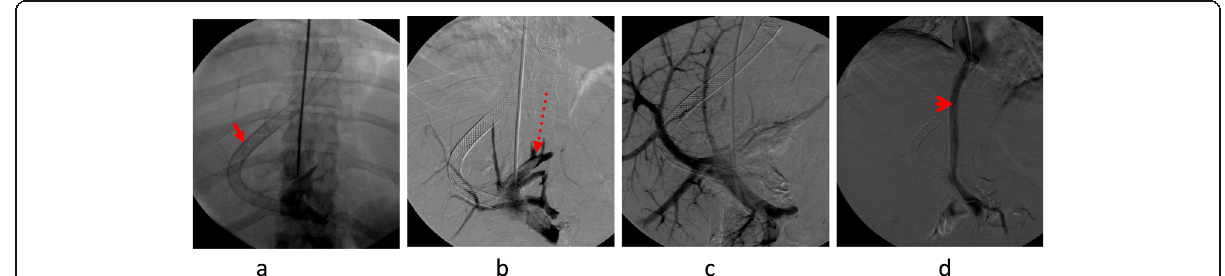
Fig. 5 Male patient with occluded long and curved (arrow) TIPS-shunt ( a ). Left portal vein was approached followed by left portography (interrupted arrow) ( b ). Then, the main portography was done to measure the pressure ( c ). Finally, the Wallstent (arrowhead) that was delivered shows a straight course between the left portal and cava with an excellent flow ( d )